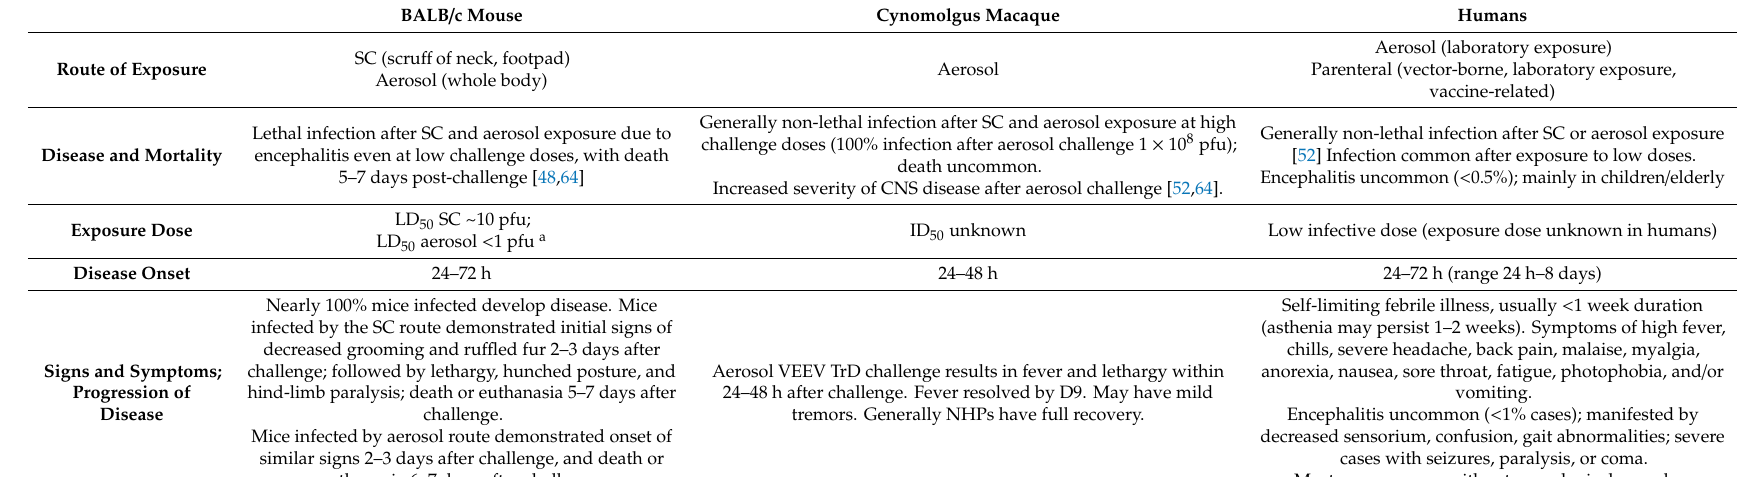
Table 4. Summary of the selected VEEV IAB TrD strain in mice, NHPs, and